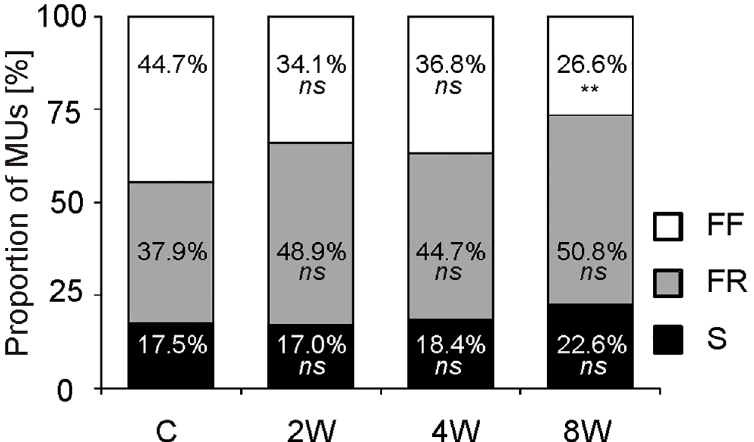
Fig 2. Distribution of three types of motor units in control and trained animals. Distribution of the three motor unit types of the medial gastrocnemius muscle in the sedentary control group (C) and those trained for 2 weeks (2W), 4 weeks (4W) and 8 weeks (8W). Fast fatigable (FF) MUs are represented in white, fast fatigue resistant (FR) MUs in grey, and slow (S) MUs in black. Two-sided p-value represents the statistical significance of the training period (2, 4 or 8 weeks) with respect to the control group (Two Proportion Z-test). The symbols (cid:3) denote values significantly different: (cid:3) p < 0.05, (cid:3)(cid:3) p < 0.01, (cid:3)(cid:3)(cid:3) p < 0.001 (S3 File).